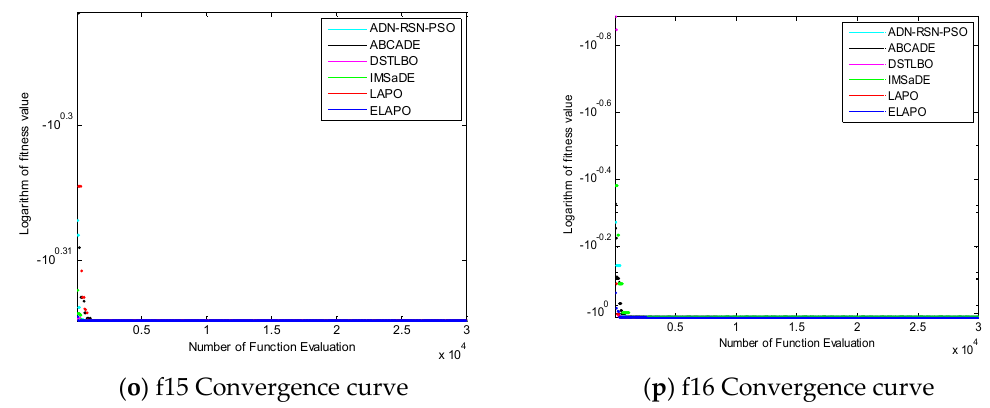
( o ) f15 Convergence curve ( p ) f16 Convergence curve Figure 4. The figure of function Figure 4. The figure of function convergence.